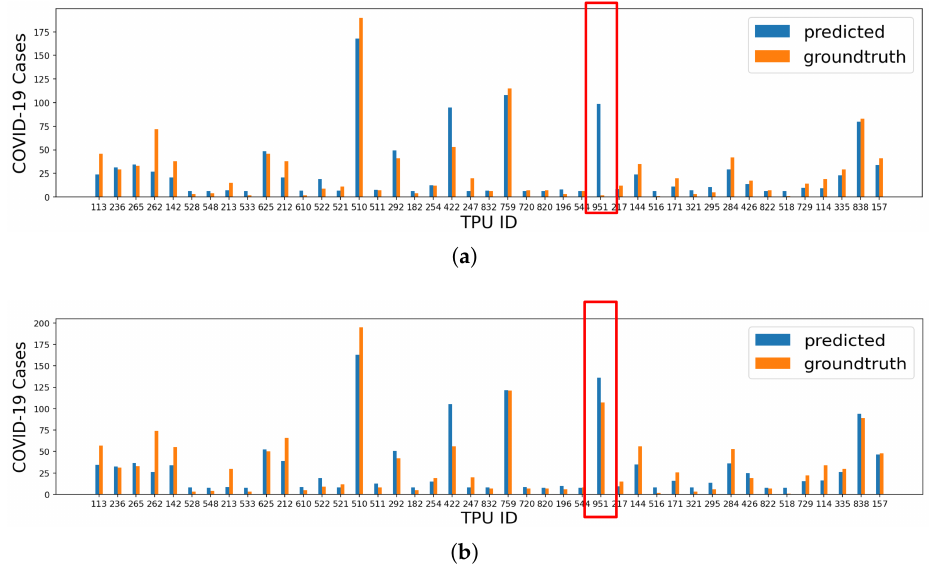
Figure 3. The prediction results of XGB for TPUs excluding the top 3 TPUs. ( a ) Prediction results of local cases for TPUs excluding the top 3 TPUs ( R 2 all cases for TPUs excluding the top 3 TPUs ( R 2